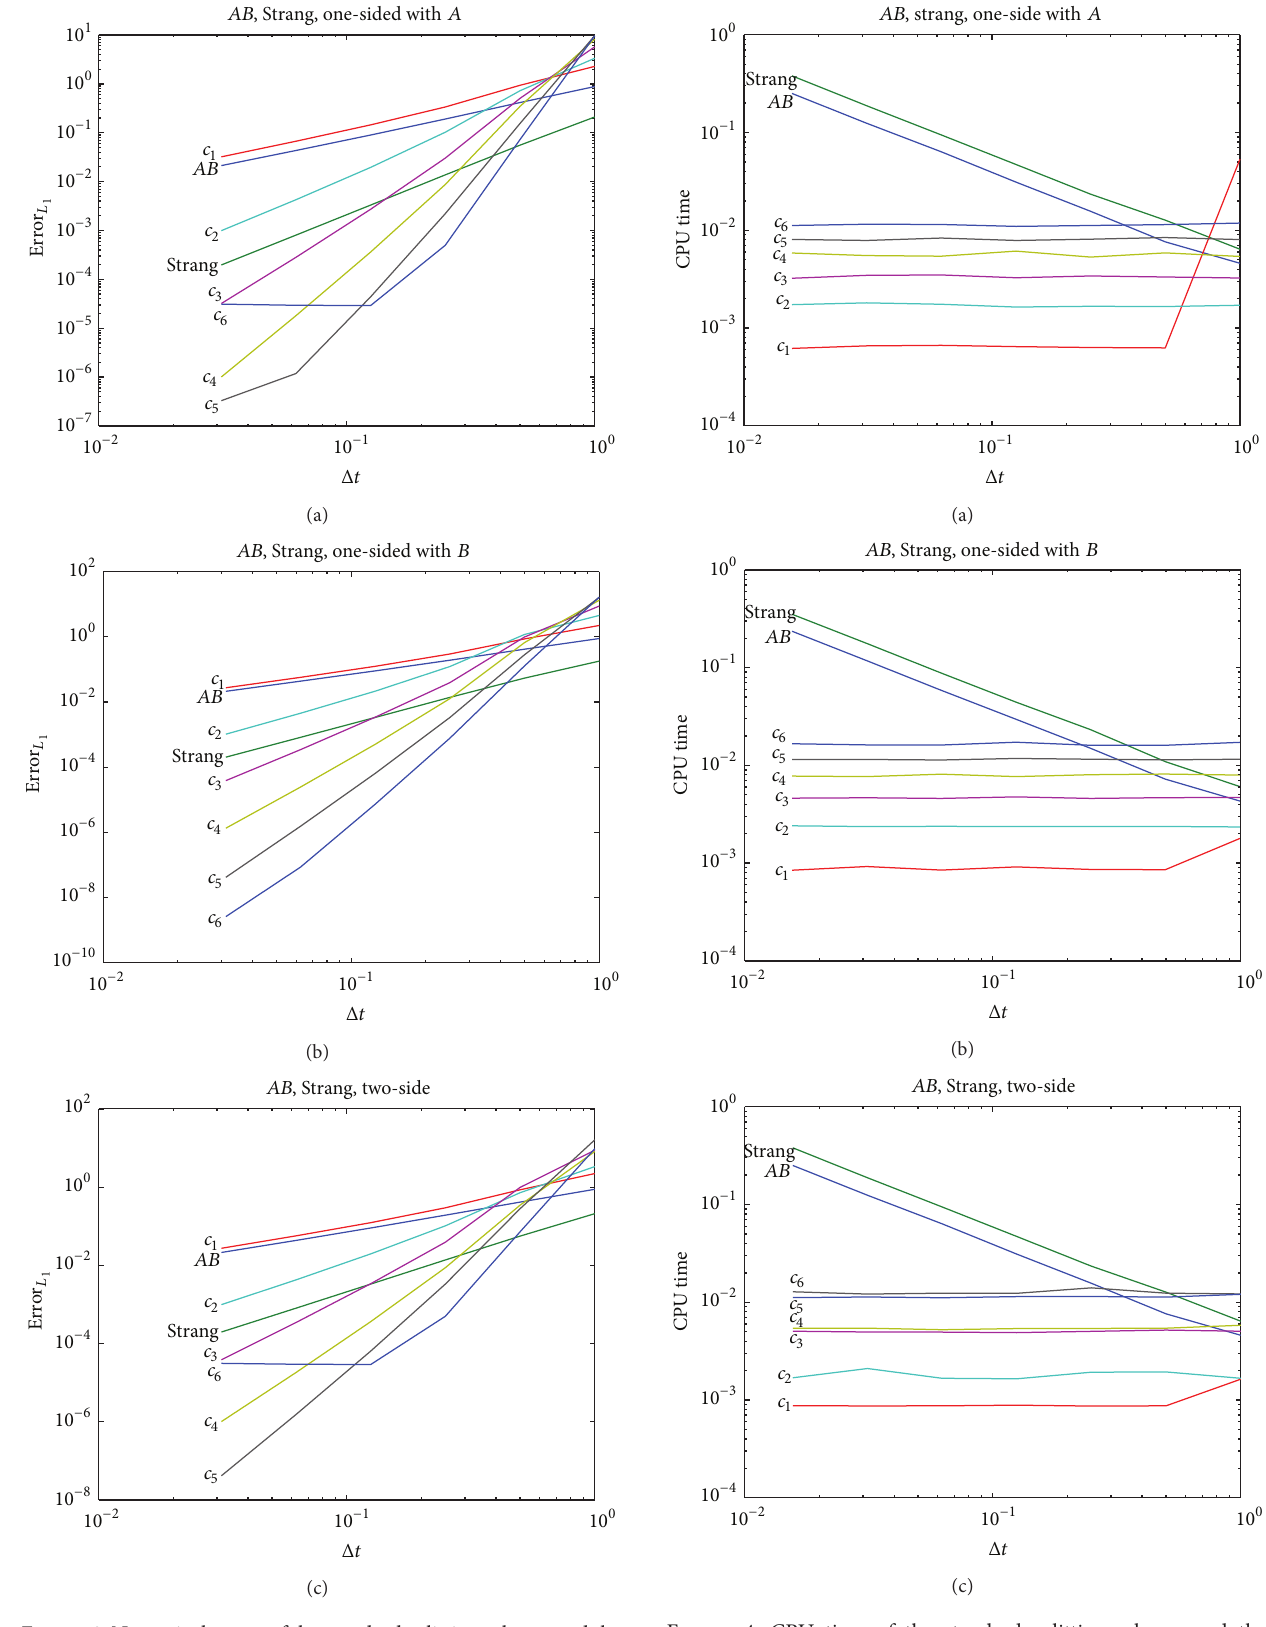
Figure 3: Numerical errors of the standard splitting scheme and the iterative schemes with the Zassenhaus formula, where we have at least 1,...,4 iterative steps.